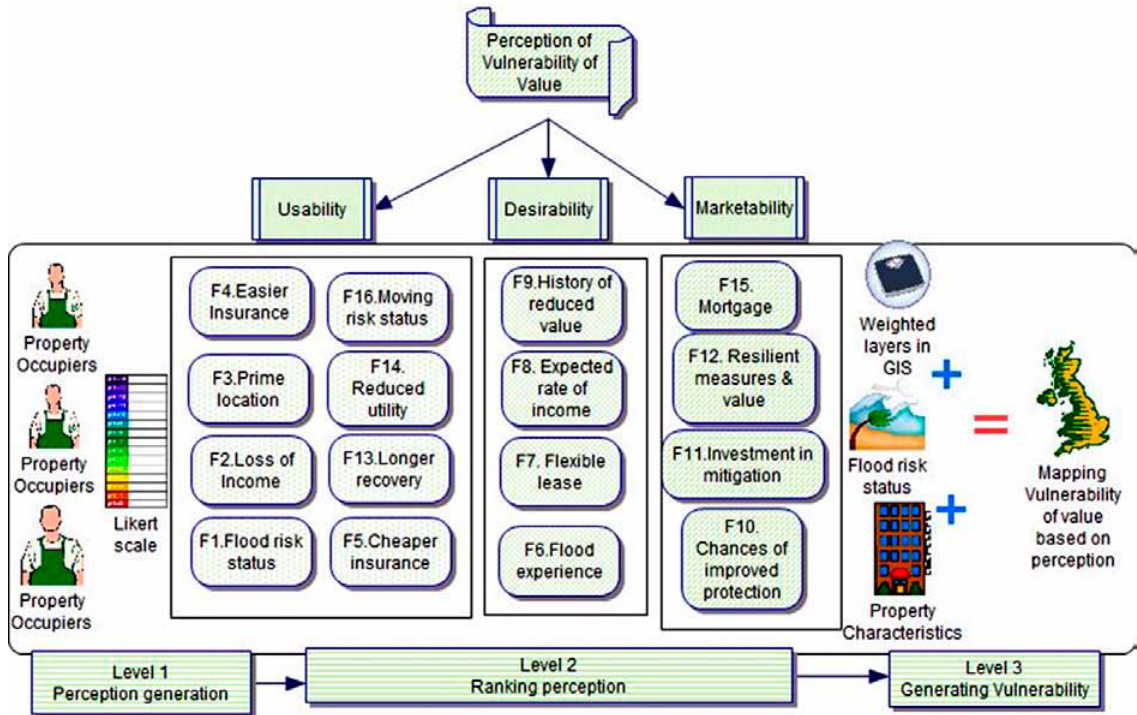
fig. 1. Spatial ranking model for deriving vulnerability of value of commercial properties based on flood risk